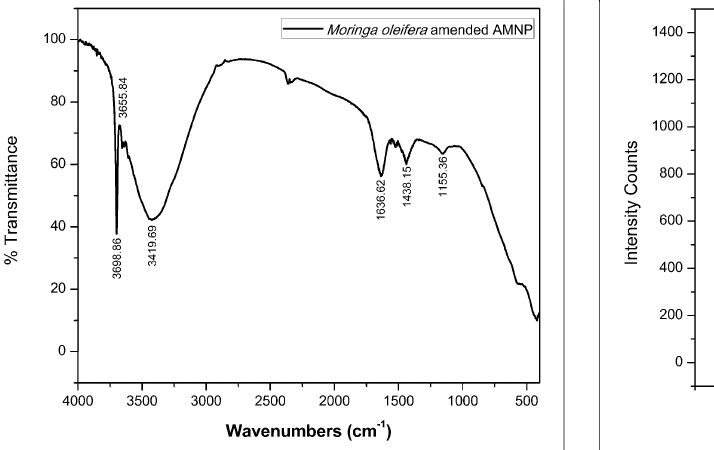
Fig. 2 FTIR spectrum of AMNP Fig. 3 XRD pattern of the